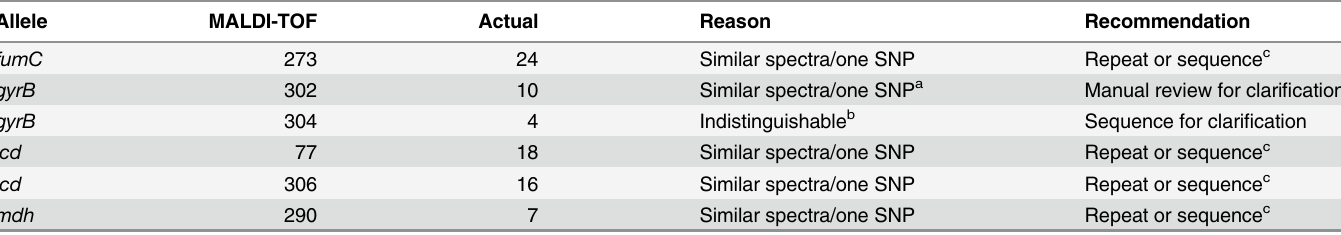
Table 1. Examples of discrepancies between MLST by MALDI-TOF MS and sequencing.